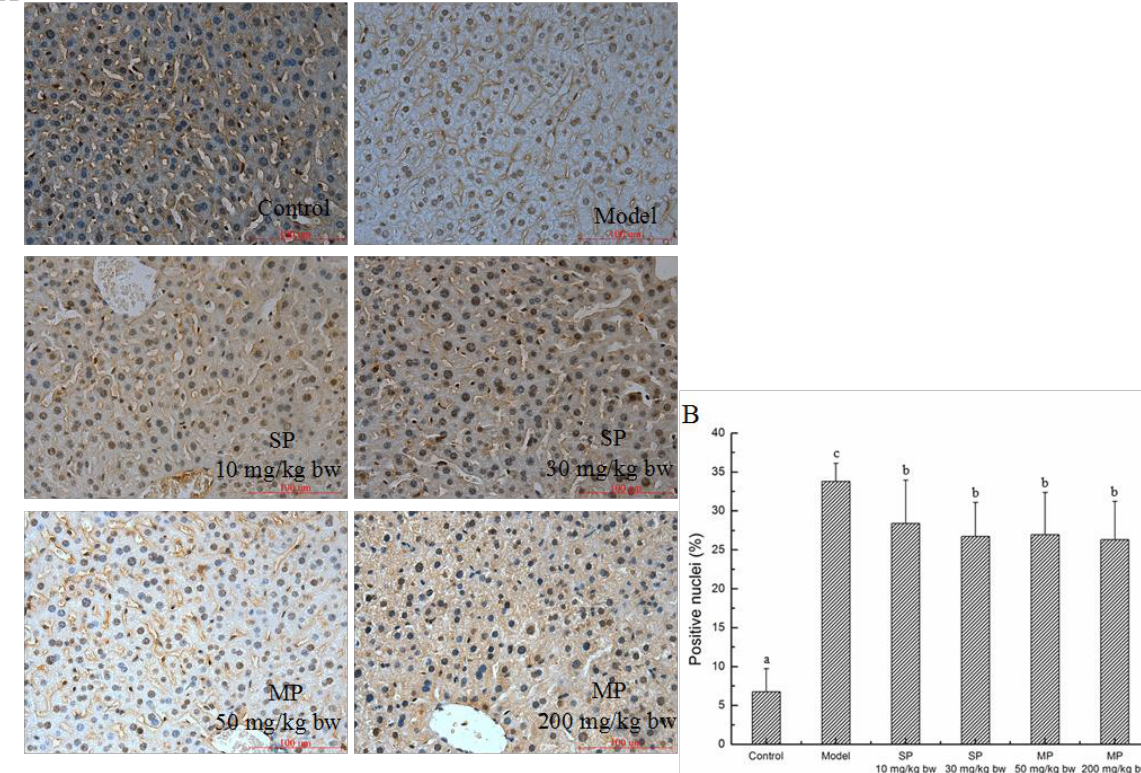
Figure 8. Detection of apoptotic hepatocytes by TUNEL assay in each group. ( A ) Representative images from each group and various administrations are shown at 400× magnifications; ( B ) TUNEL positive cells ratio. Values not sharing a common letter (a, b, c) differ significantly at p < 0.05. SP, synthetic pentapeptide; MP, mixed corn